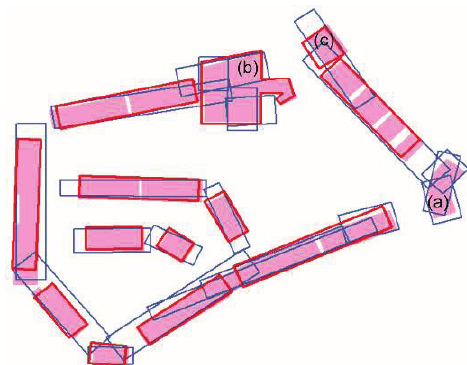
Figure 4. Result of roof growing approach